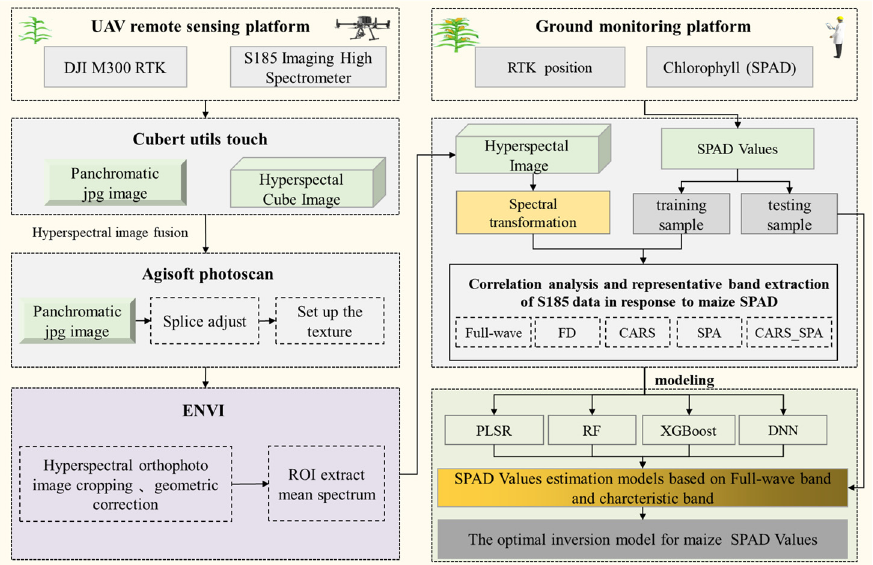
Figure 3. Flow chart of summer maize SPAD values estimation model.